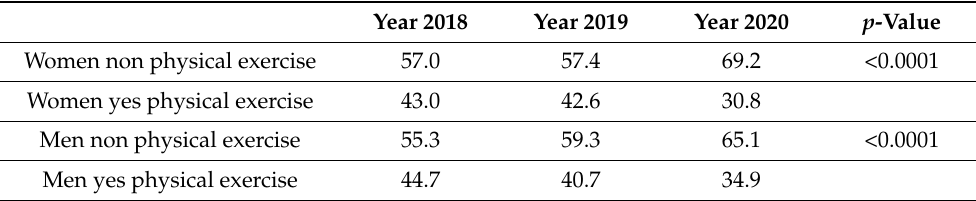
Table 5. Percentage of physical activity, before and during lockdown in men and women separated into groups according to whether or not they previously performed physical